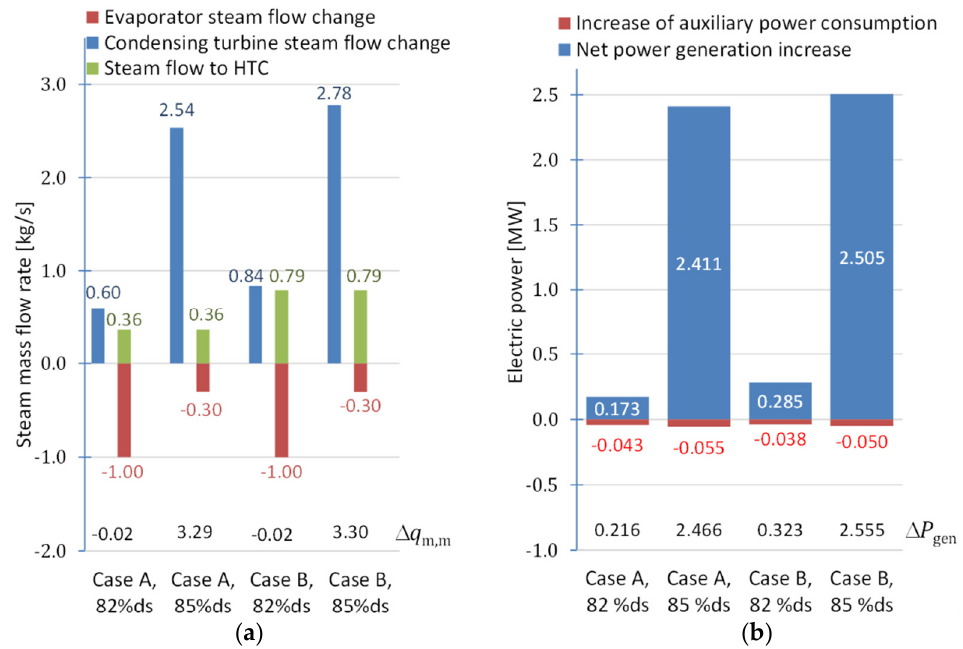
Figure 4. Change of NorPulp plant steam production and use ( a ), and power generation ( b ) with HTC treatment of biosludge. Table 4. Plant performances with different NorPulp cases considered.